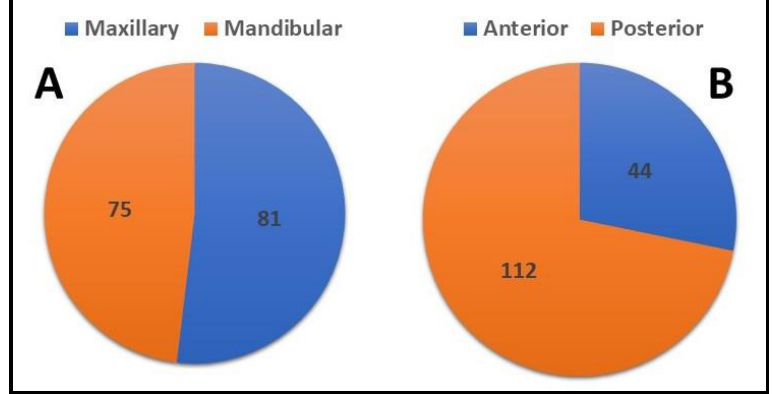
Figure 4. ( A , B ): distribution of errors encountered; ( A ): arch-wise; ( B ): location-wise.